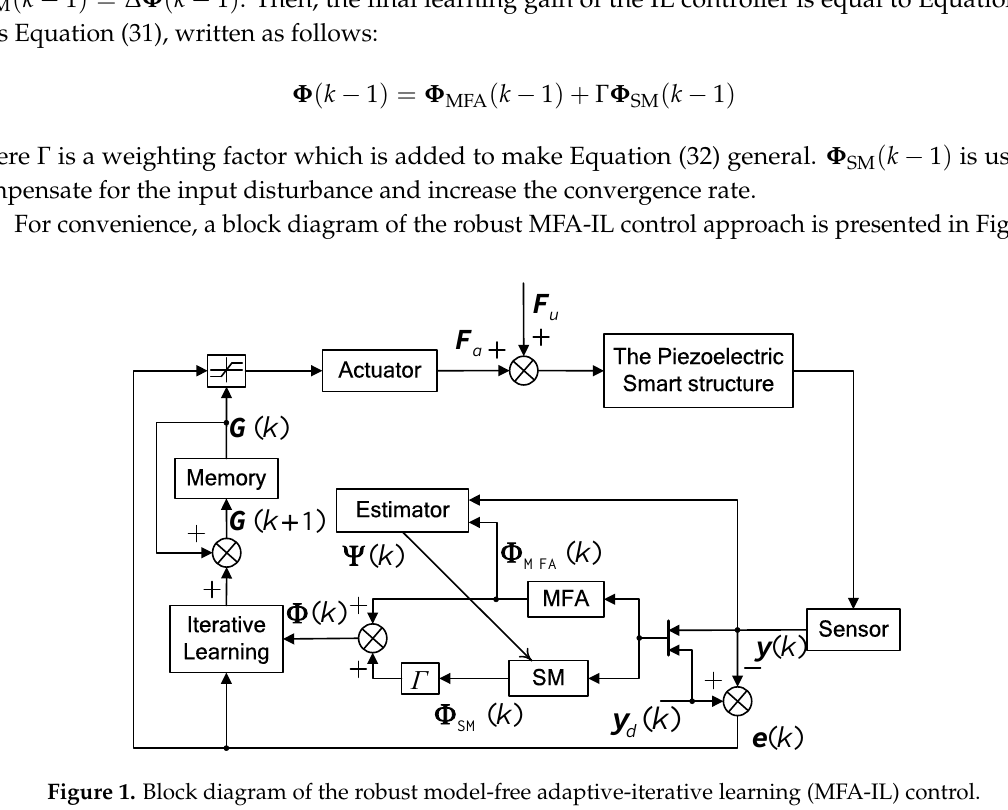
Figure 1. Block diagram of the robust model-free adaptive-iterative learning (MFA-IL) control.